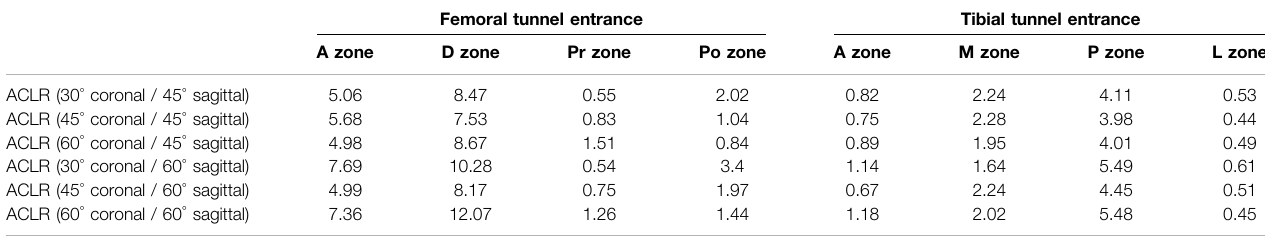
TABLE3| MaximumvonMisesstress(MPa)atdifferentzonesofthetunnelentrancesfollowingACLRbyAMportaltechniqueinseveralcoronalandsagittalobliquityangles.